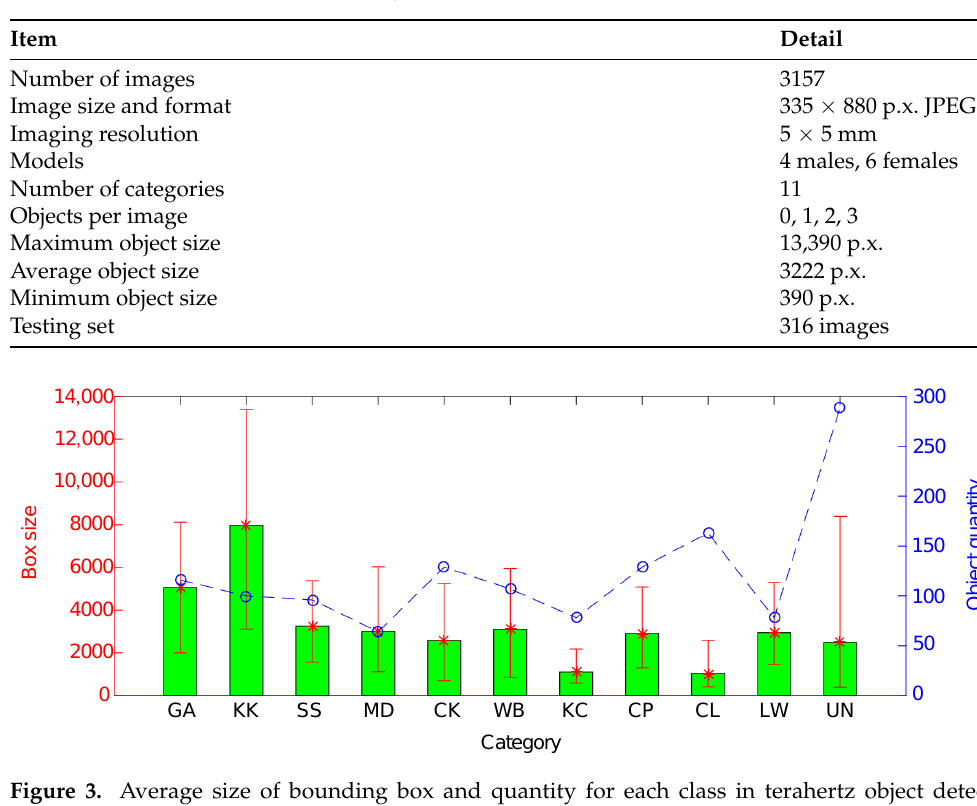
Table 2. Detail statistics of terahertz object detection dataset.